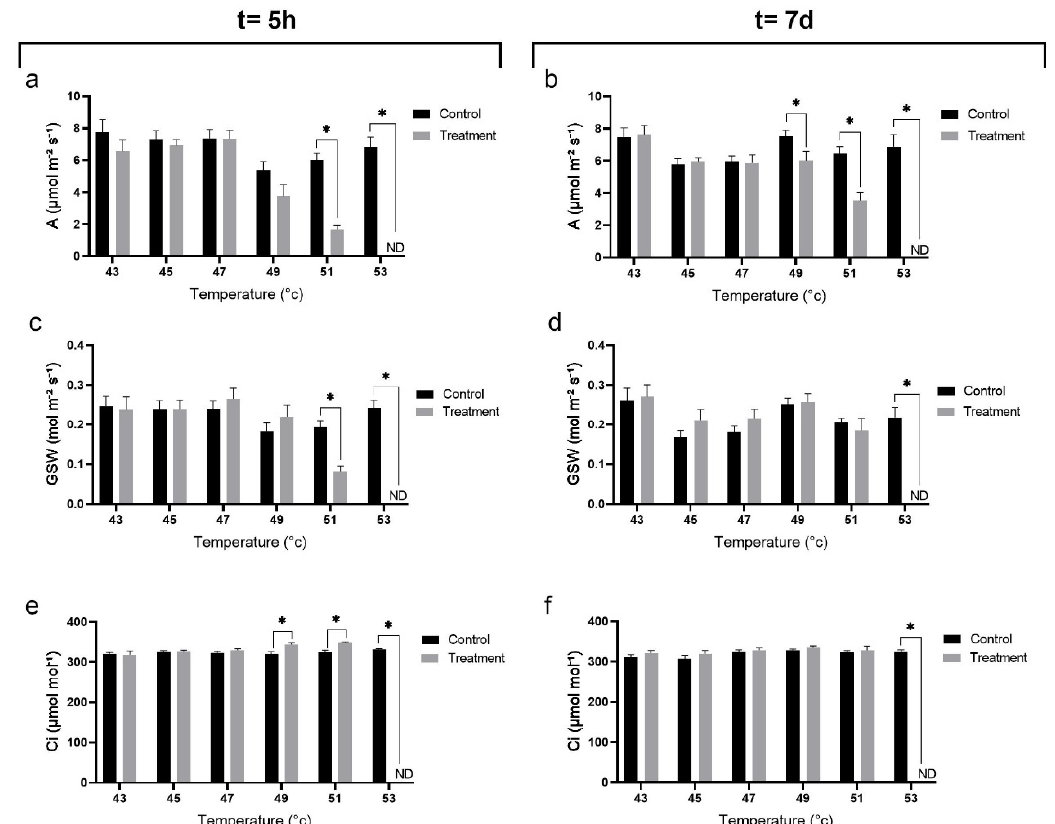
Figure 4. Gas-exchange parameters were measured after exposure to sunlight following temperature treatments: A–CO 2 assimilation, GSW–stomatal conductance to water vapour, and Ci–substomatal internal CO 2 concentration. Measurements were taken after incubation in the climate chamber (treatment), following five hours of exposure to sunlight in the net house ( a , c , e ; t = 5 h), and at midday after seven days in the net house ( b , d , f ; t = 7 d). Plants that were not exposed to the different heat treatments were used as control (control). Each treatment was replicated four times with four different plants for each replicate. Values are means ± SE of at least four different leaves on each of the 16 plants ( n = 16). Columns marked with an asterisk differ significantly (Student’s t -test, * , p < 0.05).